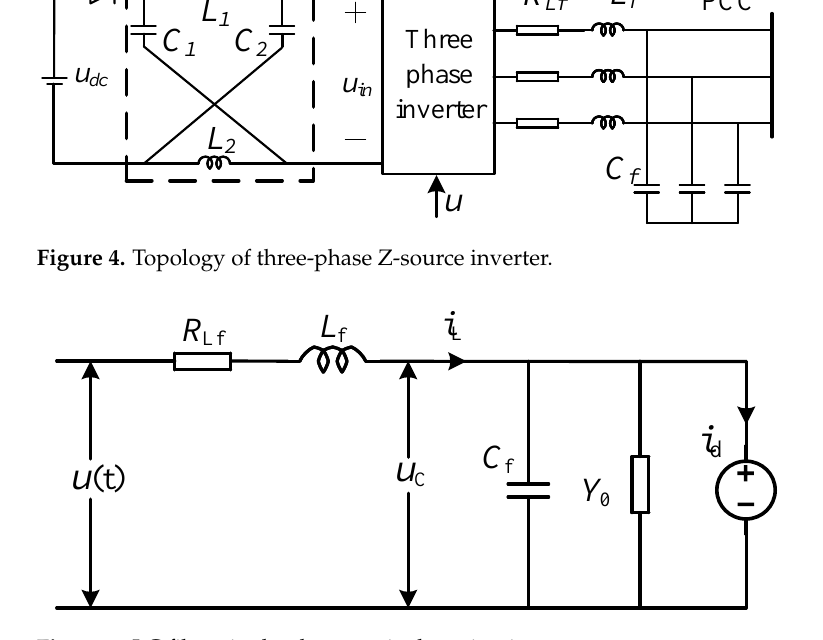
Figure 5. LC filter single-phase equivalent circuit.